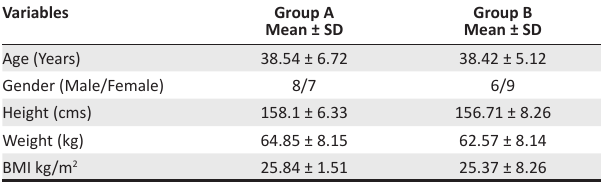
TABLE 1: Baseline characteristics.